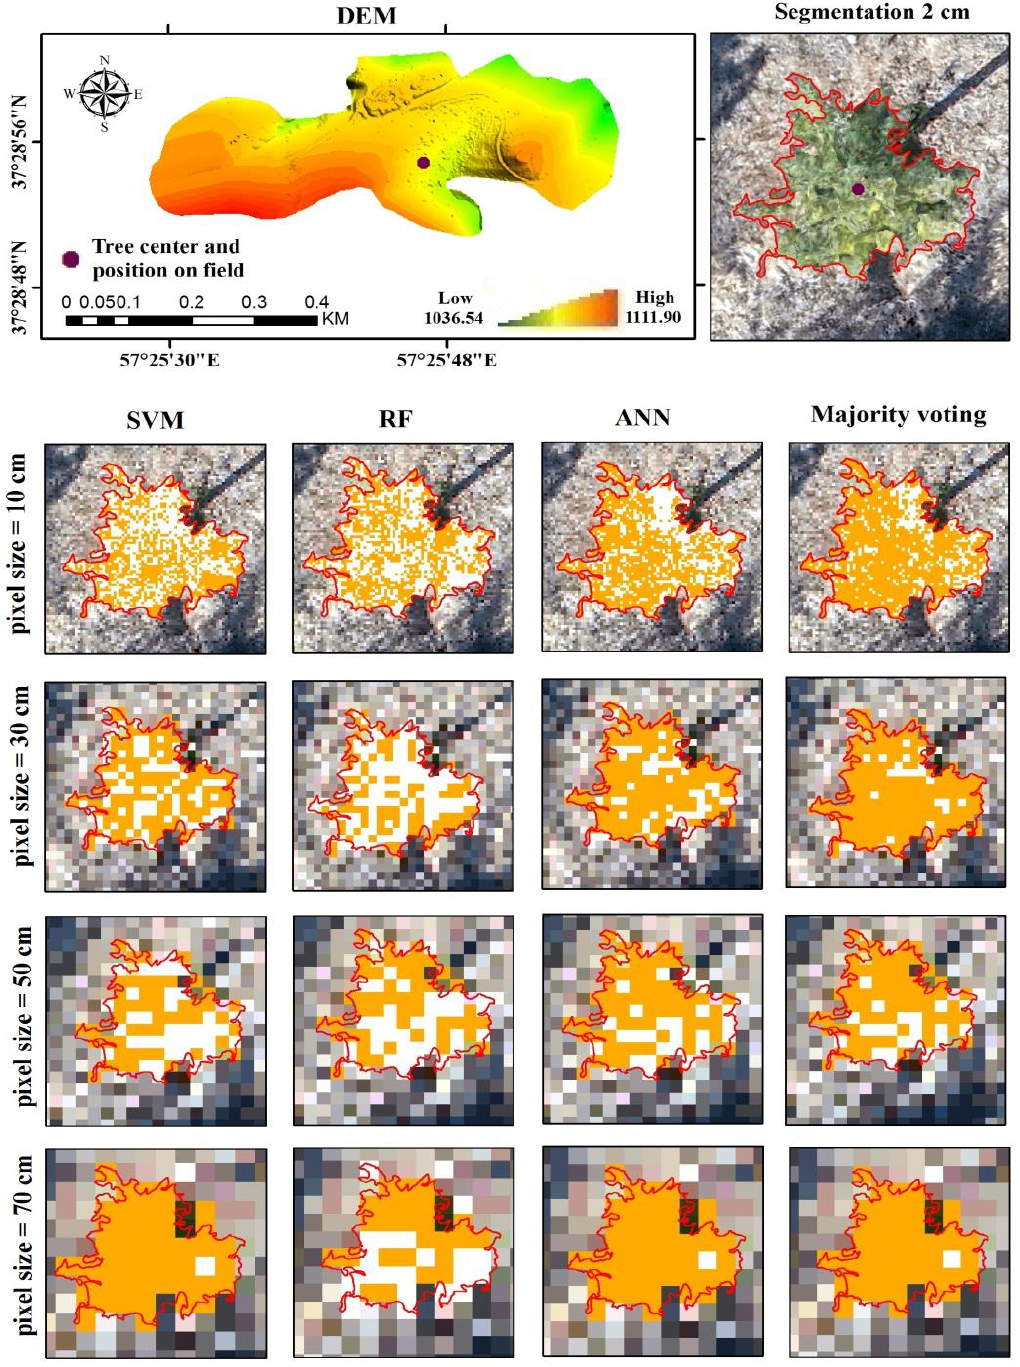
Figure 3. A part of classification results of SVM (Support vector machine), RF (Random forest) and ANN (Artificial neural network) used to delineate Pinus eldarica tree crowns (red polygons) on UAV orthoimages with pixel sizes of 10, 30, 50, and 70 cm. The red polygon is the true crown boundary obtained from segmentation of the 2-cm resolution orthoimage overlaid on the orthoimages with different pixel sizes for visual